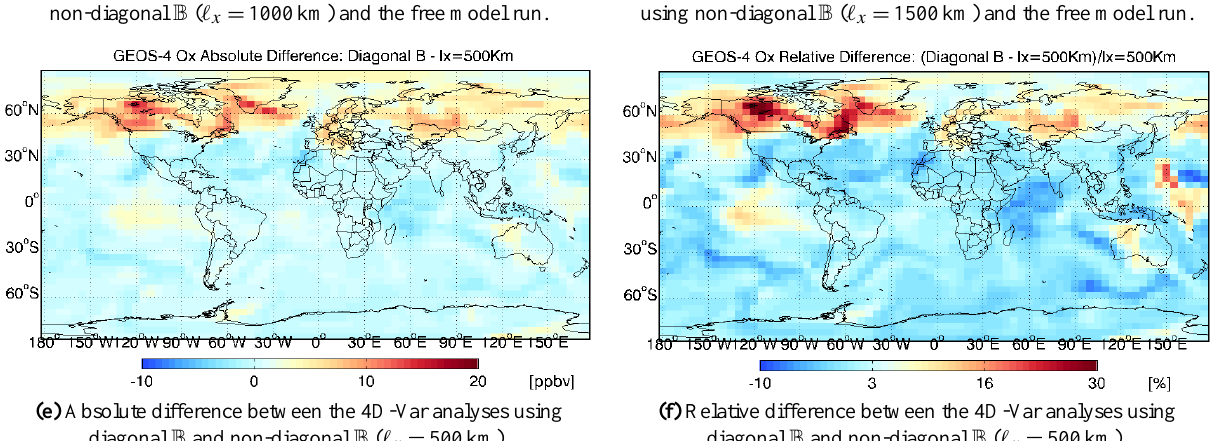
Fig. 7. Differences in global ozone concentrations at 00:00GMT on 6 August 2006 (end of assimilation window) averaged over the first 10 GEOS-Chem vertical levels. (a) – (d) Differences between the 4D-Var analysis fields and the model forecast (solution without data assimilation); the analyses use different correlation lengths between 0km and 1500km. (e )– (f) Absolute and relative differences between 4D-Var analyses using diagonal and non-diagonal background covariance